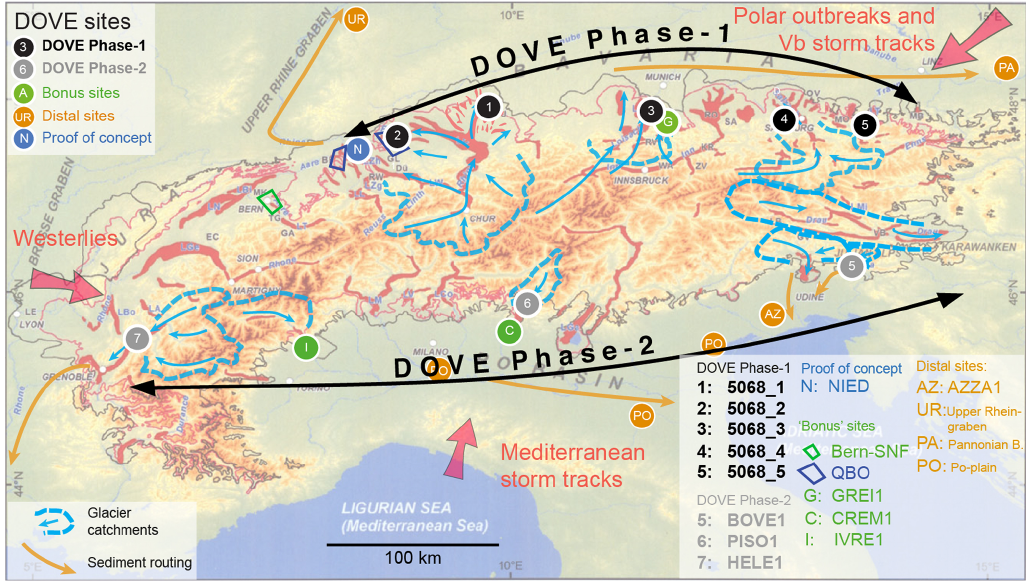
Figure 6. Location of primary DOVE Phase 1 sites (black), Nagra QBO sites (11 sites within the blue areas), Phase 2 sites (grey), and bonus sites (green) in the Alpine region, with limit of the Last Glacial Maximum (pink line), maximum limit of Pleistocene glaciation (black line), location of overdeepened structures (red) and pathways of major moisture sources (red arrows) (after Preusser et al., 2010). Indicated are glacial catchments related to the drill-site areas (dashed blue lines) and main paleo-ice-flow directions (blue arrows). Orange circles indicate distal continental basins that lie in the fluvial sediment pathways (arrows) and provide a more continuous but indirect record of